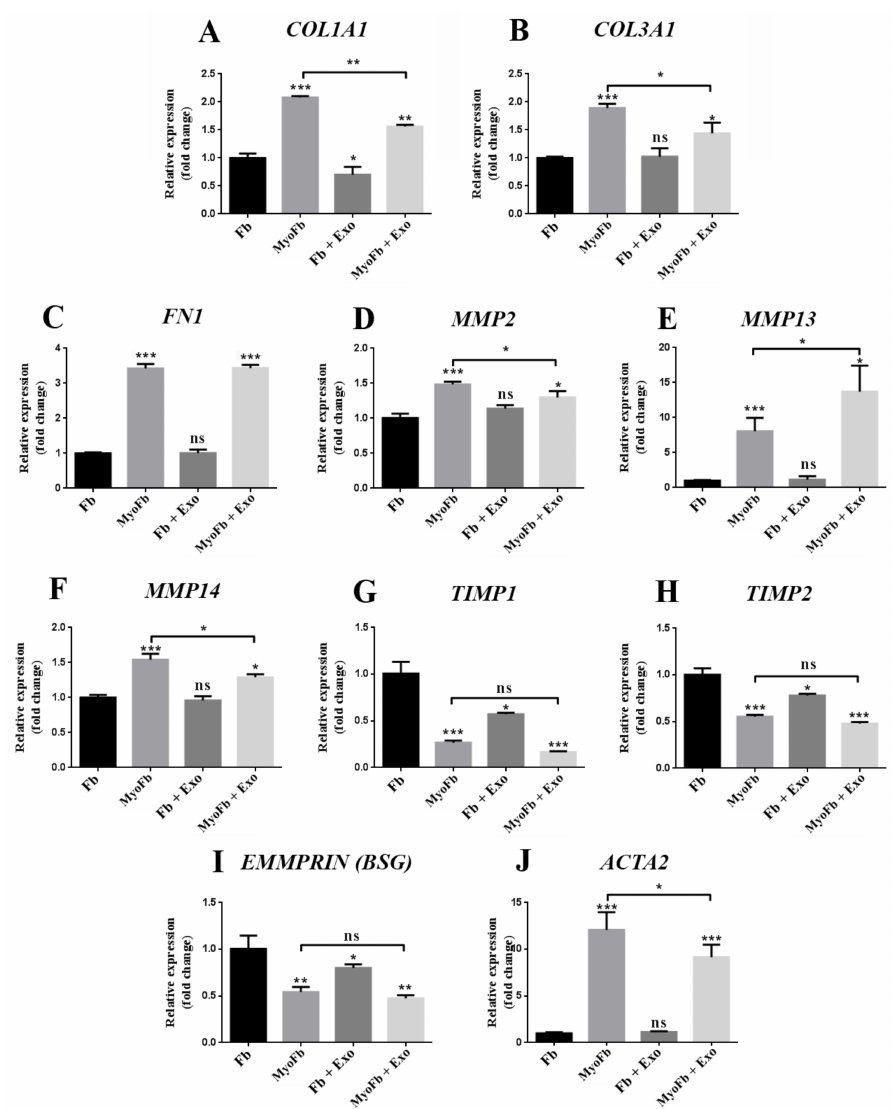
Figure 6. Exosomes modulate the gene expressions of several structural proteins and enzymes involved in matrix remodeling and contractility. The graphs represent the relative mRNA levels of selected genes obtained via qPCR for dermal fibroblasts in normal conditions (control), fibroblasts differentiated towards a myofibroblast phenotype with TGF β 1, fibroblasts incubated with exosomes (Exo), and myofibroblasts exposed to exosomes. COL1A1 —type I collagen, COL3A1 —type III colla- gen, FN1 —fibronectin, MMP —matrix metalloproteinase, TIMP —tissue inhibitor of metalloproteinase, EMMPRIN ( BSG )—extracellular matrix metalloproteinase inducer, ACTA2 — α -smooth muscle actin. Data are means ± SD ( n = 3), * p < 0.05; ** p < 0.01, *** p < 0.001, ns—not